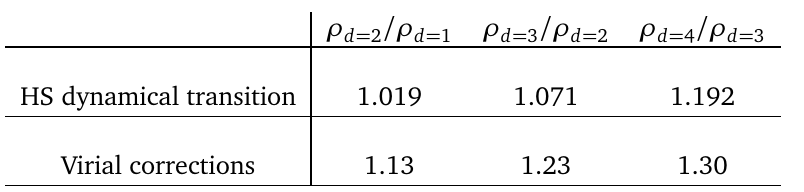
Table 2: Density ratios used in Fig. 6 to compare different dimensions from d = 1 to 4. The first method (first line) gives ratios between the dynamical transition densities ( d ) extracted from Refs. [ 49,53 ] . One-dimensional hard spheres for hard spheres ρ HS d do not exhibit such a slowing down, so for d = 1 we considered the dense regime to occur at the maximal packing fraction (unity). The second method (second line) is ( d , T ) (App. based on the calculation of ρ Z